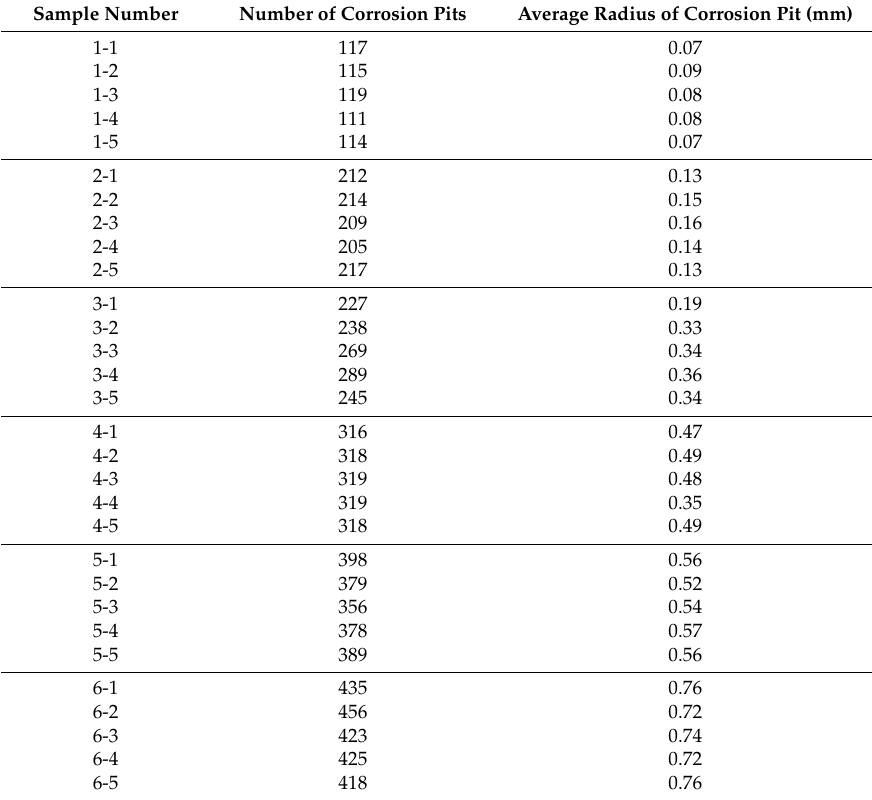
Figure 4. Non-contact 3D scanner. Table 2. Number and radius of steel wire corrosion pits with di ff erent degrees of corrosion. Sample